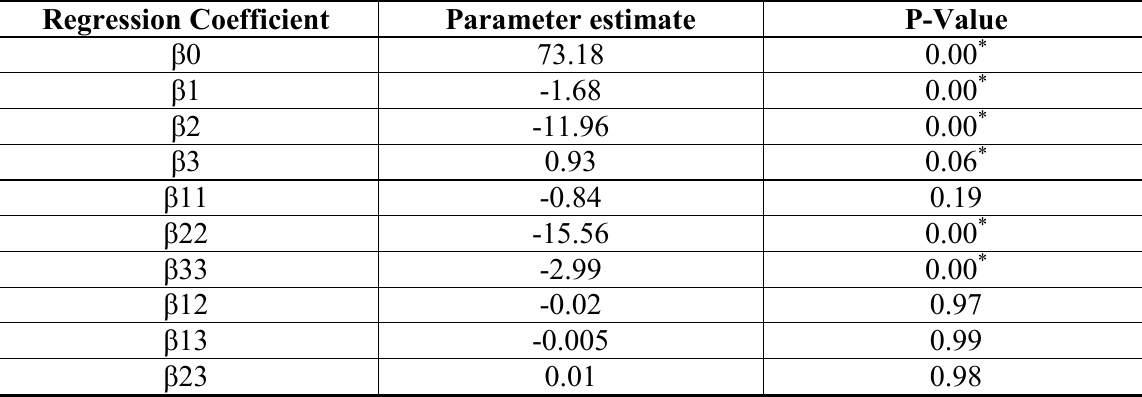
Table 3. The model regression coefficient